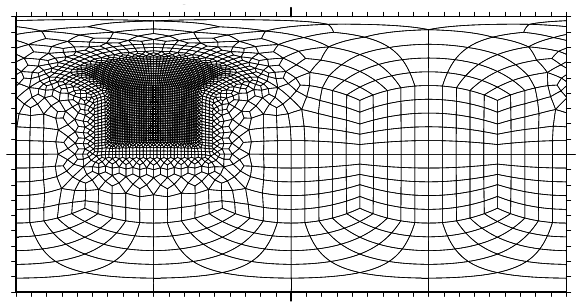
Figure 4. Example of × 8 refined grids with (cid:49)x low = 3 ◦ and (cid:49)x high = (cid:49)x low / 8.